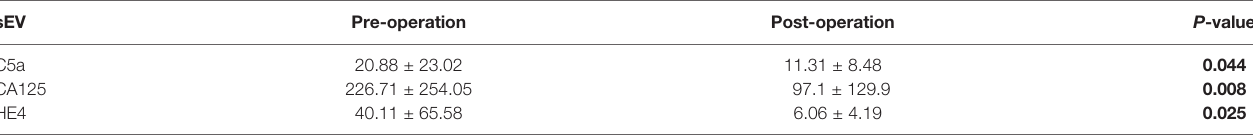
TABLE 7 | Comparison of serum sEV protein levels before and after cytoreductive surgery. sEV